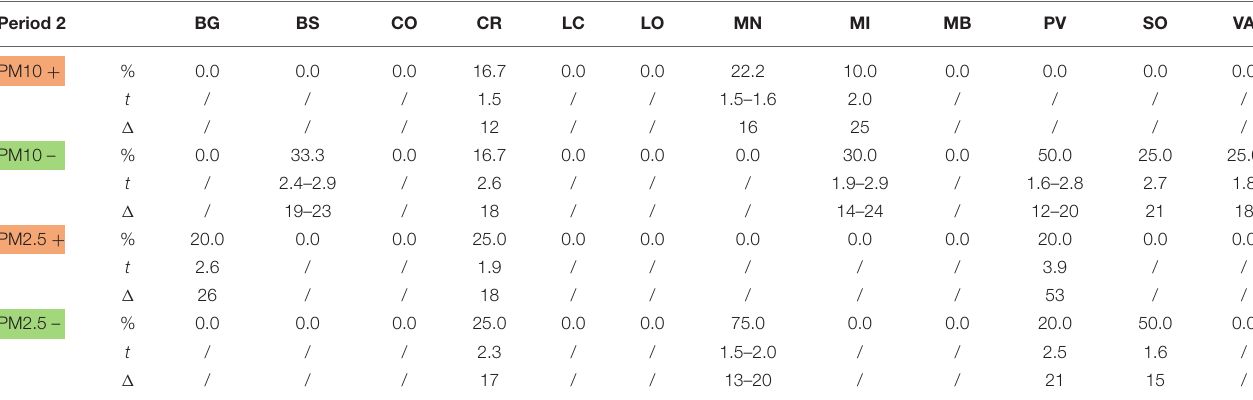
TABLE 3 | Comparison between the average concentrations of PM10 and PM2.5 in period 2 (9 March − 18 May 2018 and